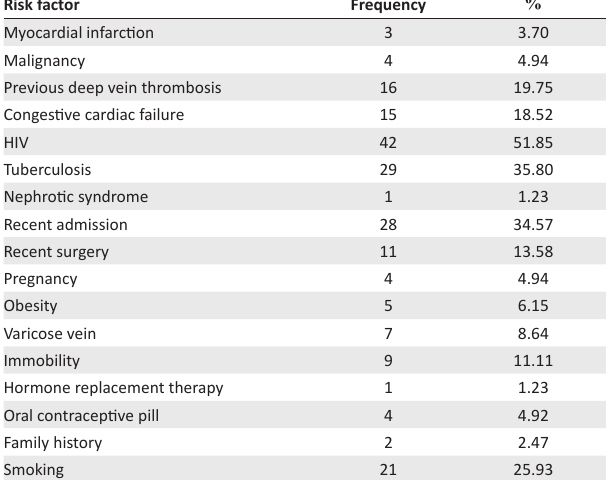
TABLE 4: Observed risk